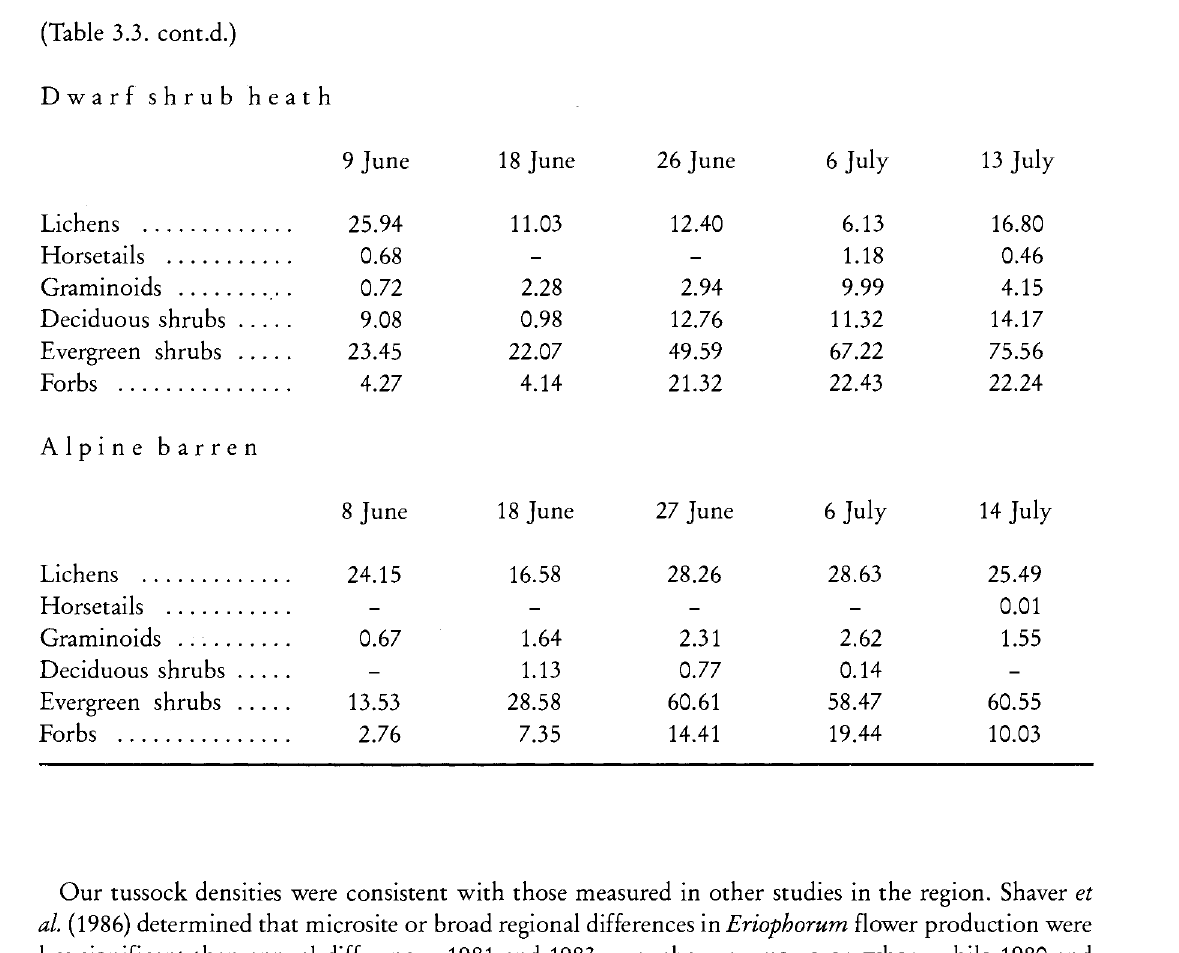
(Table 3.3. cont.d.)